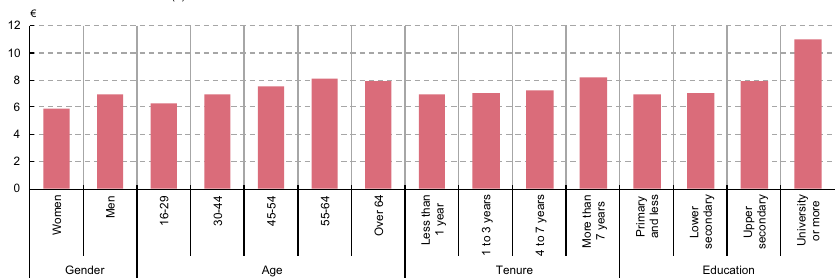
Fig. 2 Wage differentials by socioeconomic groups. a. The values reported in the graph are calculated in the following way: first, we estimate a Mincer regression of the logarithm of real hourly wages on dummy variables for gender, age, education, length of service, firm size, working hours and contract type, for the sample of all wage-earners. The omitted categories in the estimations are: man, age 30–44, primary educationorless,tenurelessthan1year,firmsize10–49,part-timecontractandtemporarycontract.Second, the estimated wages reported in the graph are calculated as the exponential of the sum of the coefficient of each of the corresponding dummy variables and the constant term. Sources : INE (EES) and Banco de